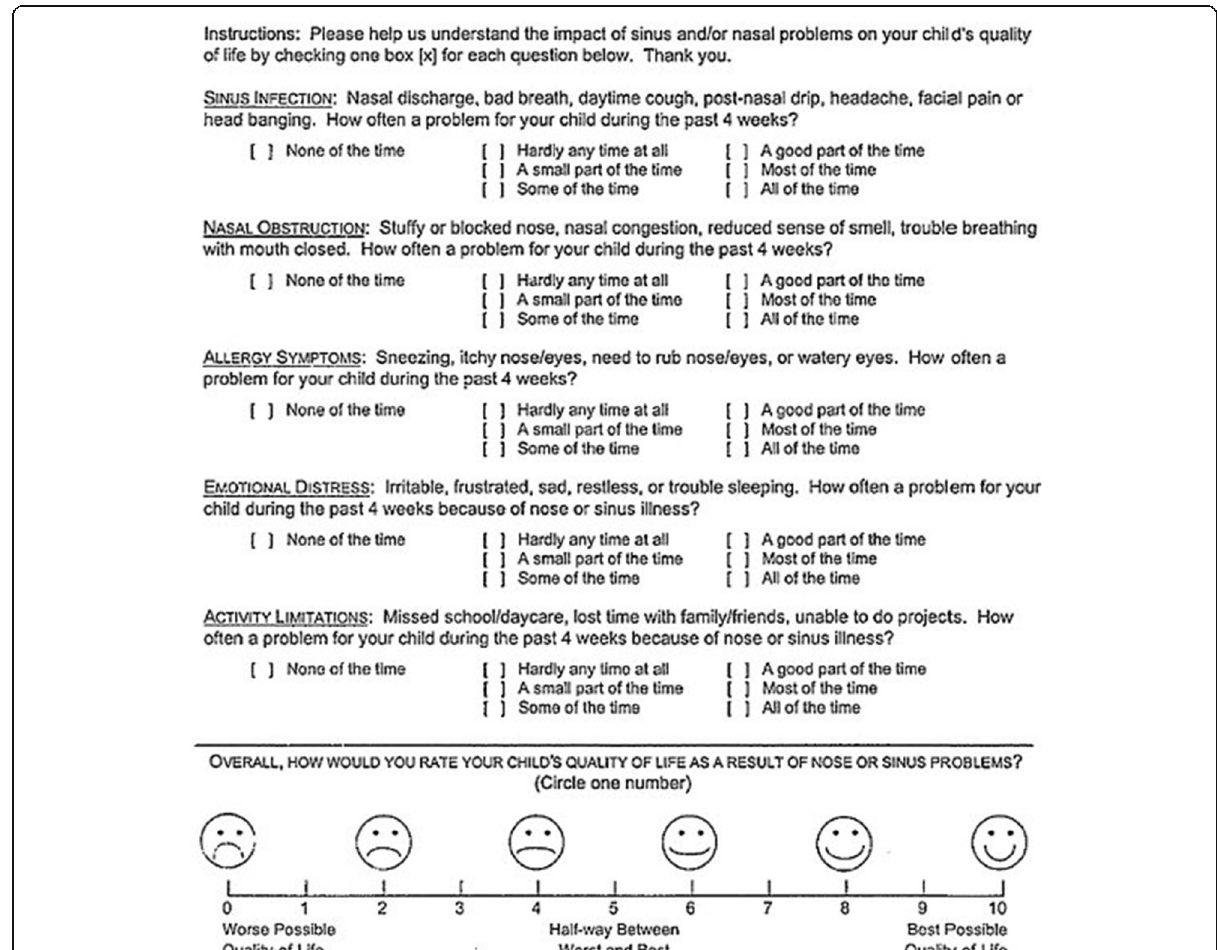
Fig. 1 The English version of “ The Sinus and Nasal Quality of Life Survey ”